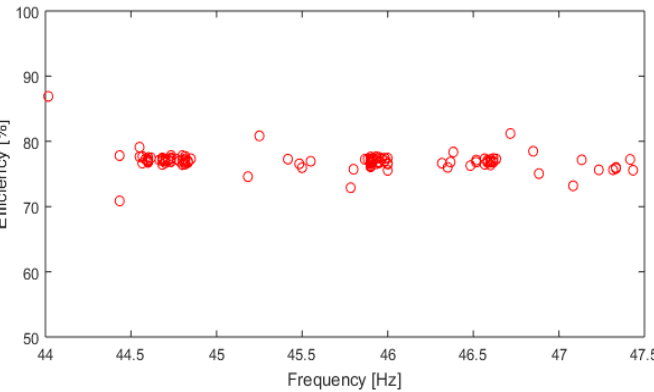
Figure 13. The characteristic F = f ( D i ) for the hydraulic regime with three pumps in operation.